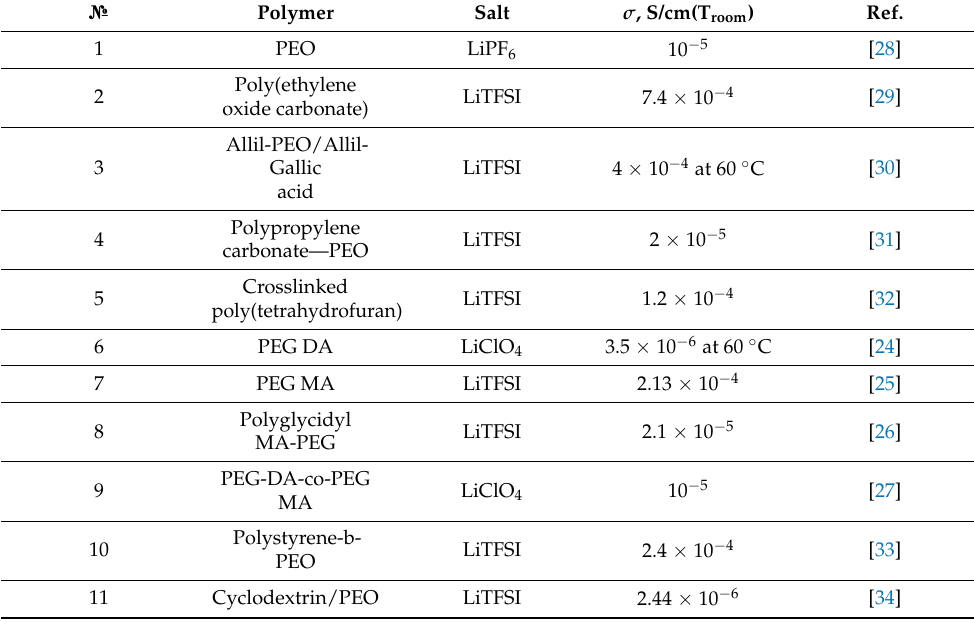
Table 1. The compositions and conductivity of some solid polymer electrolytes.